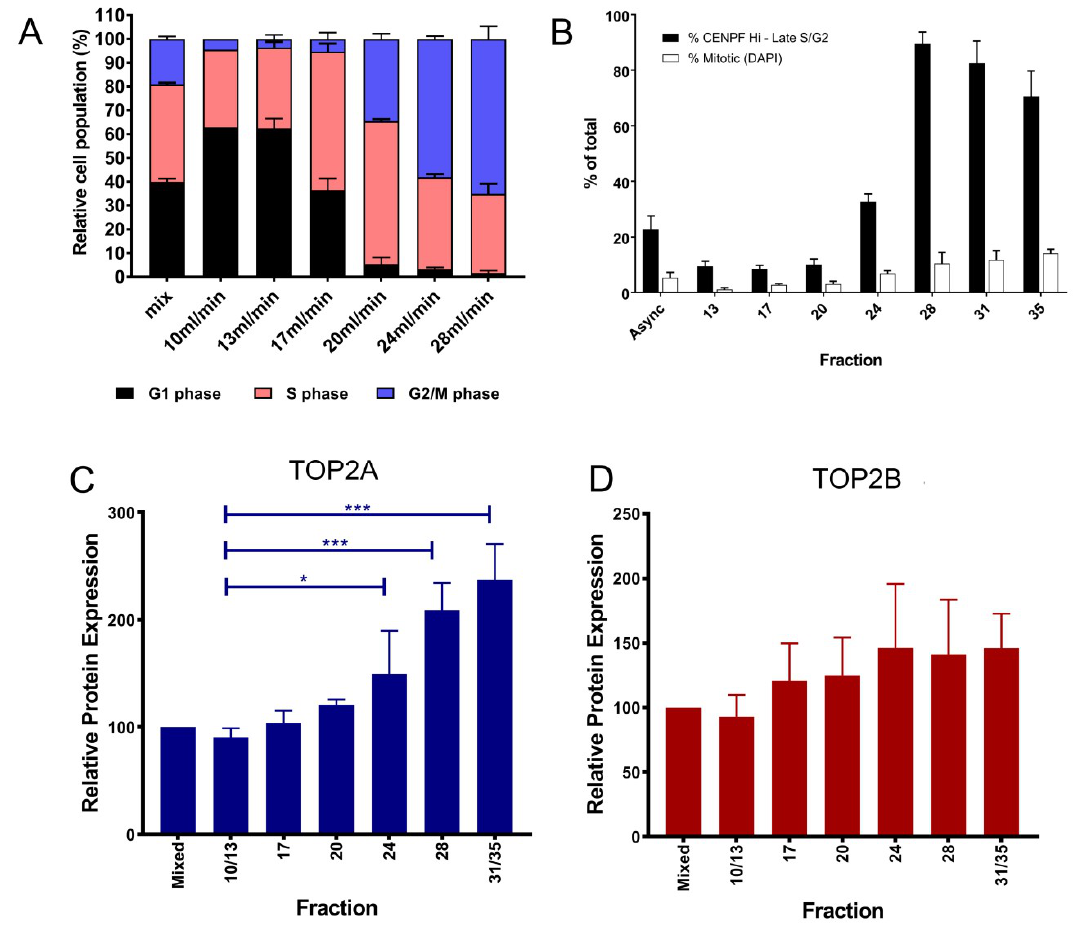
Figure 2. Elutriation of K562 cells separates the cells according to size. ( A ) FACS analysis (Flowjo) of each elutriation fraction showing the percentage of G1, S or G2/M phase cells. ( B ) Immunofluorescence analysis of each elutriation fraction showing the percentage of each fraction in lateS/G2/M determined by CENPF immunofluorescence and the percentage of mitotic cells determined by DAPI staining. ( C,D ) TOP2A and TOP2B protein level per cell was determined by quantitative immunofluorescence [77], the data shown represent the mean ± SEM of median values obtained from three replicate experiments. Statistical analysis was carried out using one way ANOVA (* p < 0.05; *** p < 0.0001).